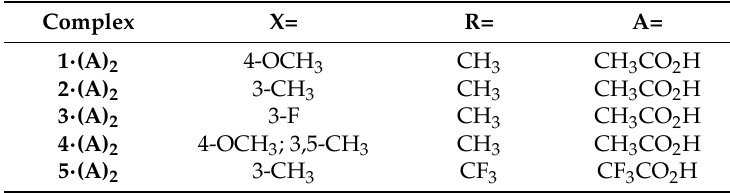
Table 1. Ligands of the rhodium compounds 1 · (A) 2 – 5 · (A) 2 . Complex